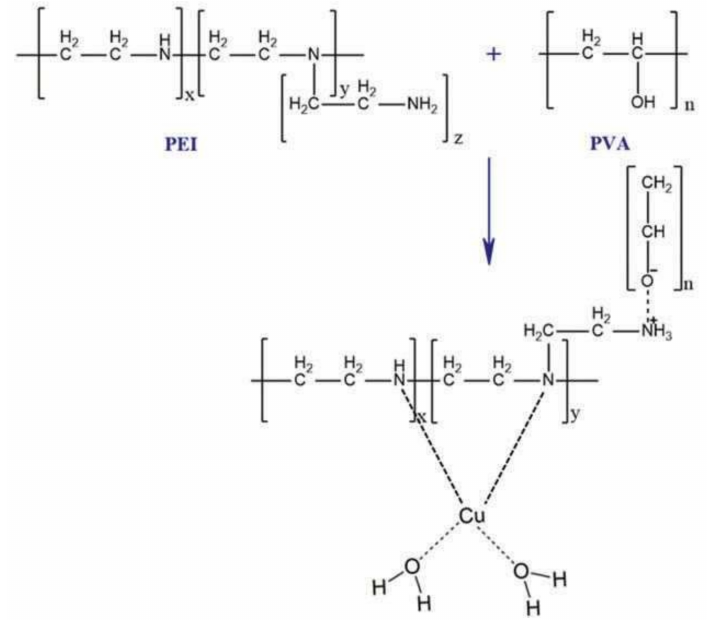
Figure 8. Copper chelation onto PVA / PEI composite cryogel. Republished with permission from [54]. Copyright 2016 Taylor &